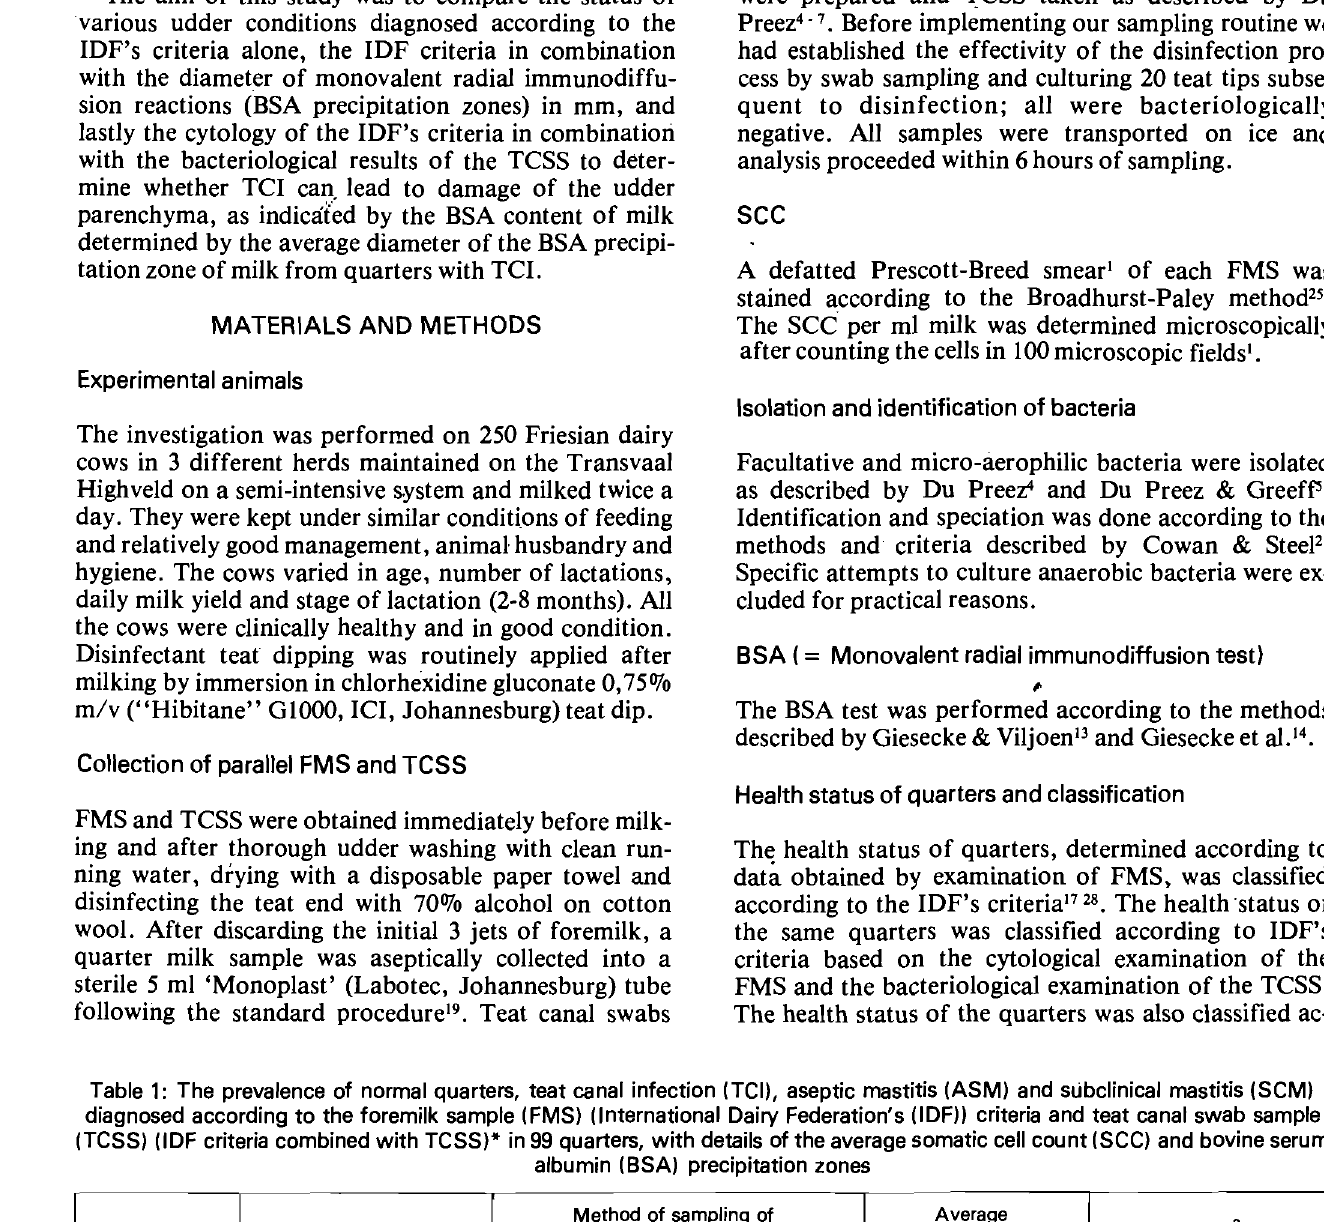
Table 1: The prevalence of normal quarters, teat canal infection (TCI), aseptic mastitis (ASM) and subclinical mastitis (SCM) diagnosed according to the foremilk sample (FMS) (International Dairy Federation's (IOF)) criteria and teat canal swab sample (TCSS) (IOF criteria combined with TCSS)* in 99 quarters, with details of the average somatic cell count (SCC) and bovine serum albumin (BSA) precipitation zones Method of sampling